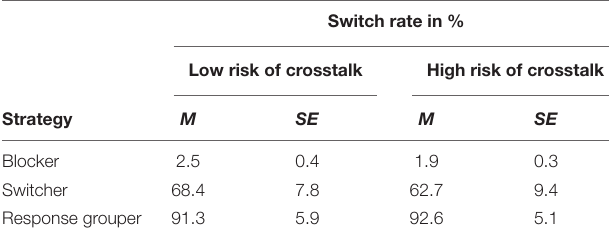
TABLE 2 | Comparison of mean switch rates between crosstalk conditions as a function of response